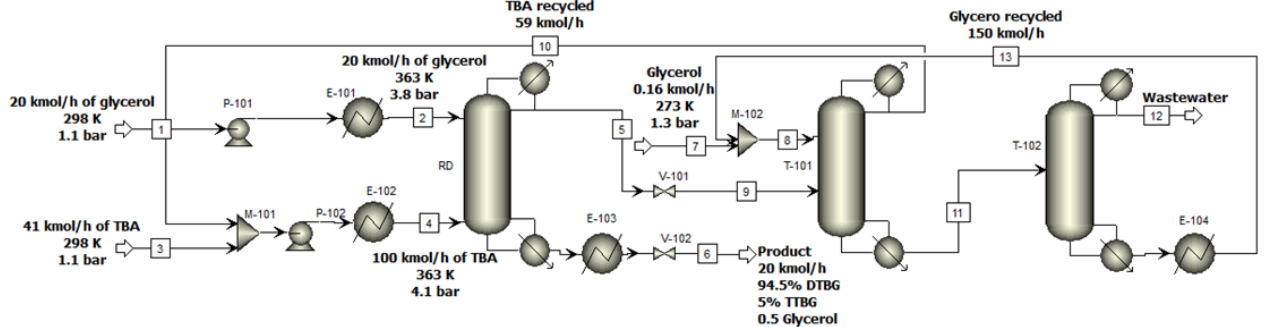
Figure 11. Process flow diagram (PFD) of the glycerol etherification with TBA using reactive distillation.